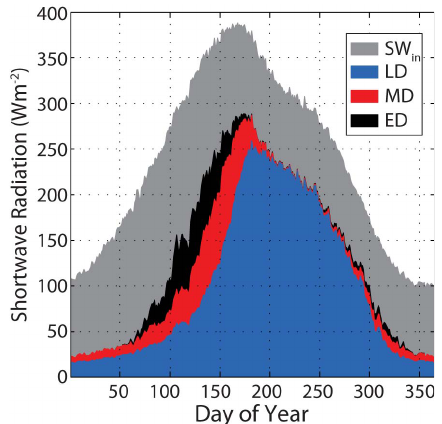
Fig. 3. Model period daily average simulated incoming shortwave radiation, and daily average net shortwave input to the snow cover under low dust (LD), moderate dust (MD), and extreme dust (ED) dust loading